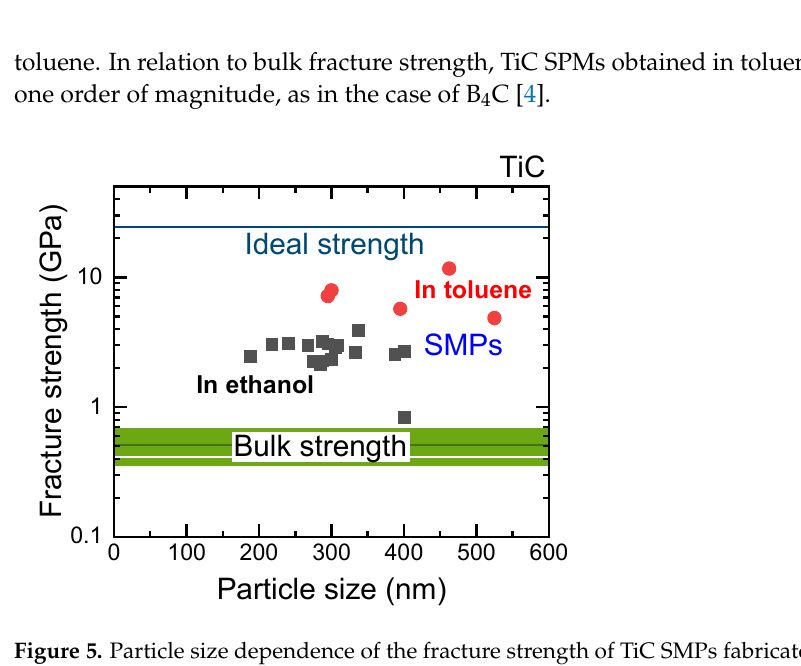
Figure 5. Particle size dependence of the fracture strength of TiC SMPs fabricated in ethanol (black squares) and toluene (red circles). The particles were placed on the SiC substrate and indented by a diamond tip. The calculated ideal tensile strengths and bulk strengths of large compact samples for TiC are also shown.